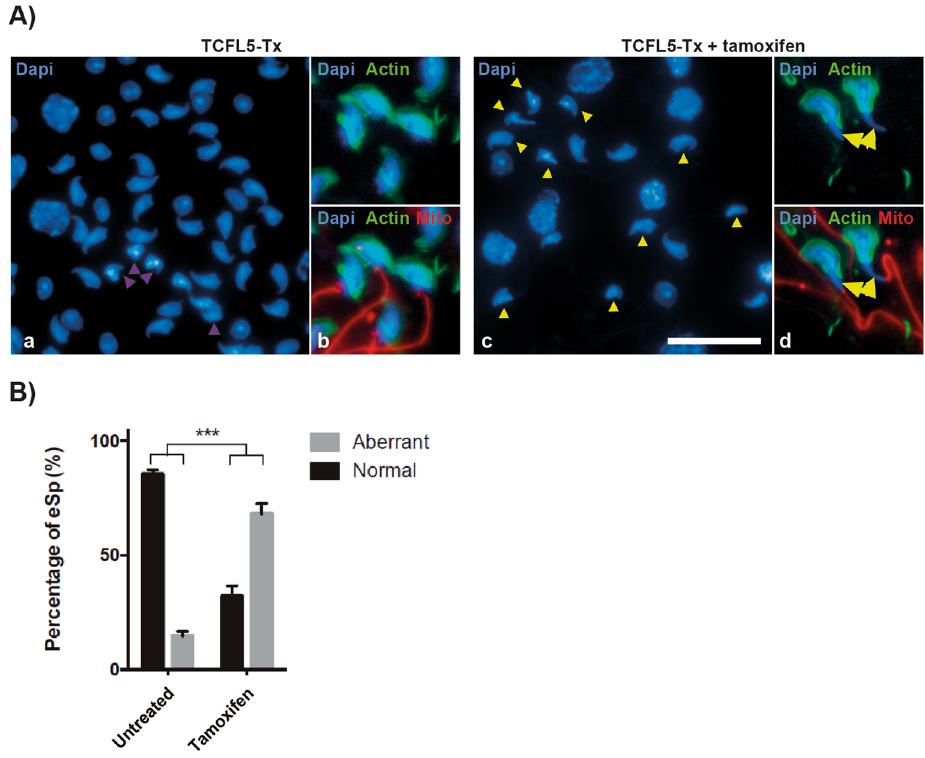
Figure 5. TCFL5-Tx treated with tamoxifen produced aberrant elongated spermatids. ( A ) Squashed eSp stained with DAPI in TCFL5-Tx non-treated and TCFL5-Tx treatesd with tamoxifen. TCFL5-Tx non-treated eSp present normal morphology (purple triangle), while most of TCFL5-Tx eSp present aberrant morphology (yellow triangle). Scale bar 20 µm. Actin (green), Mito (red) and nucleus (Dapi, Blue) were detected. ( B ) Percentage of elongated spermatids (eSp) in TCFL5-Tx non-treated and TCFL5-Tx treated with tamoxifen (TCFL5-Tx) mice. TCFL5-Tx non-treated mice produced an average of 14.6% aberrant eSp, while TCFL5-Tx treated an average of 67.9%, a 4.6-fold more aberrant eSp than TCFL5-Tx non-treated. (n = 4), t-test p < 0.001